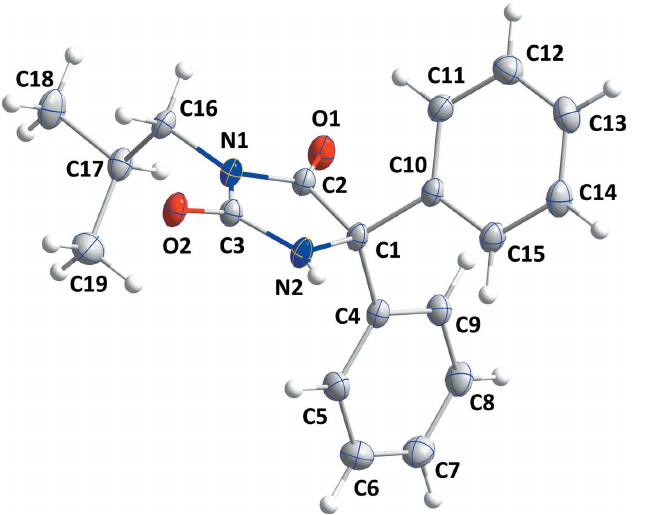
Figure 3 Packing viewed along the c -axis direction with intermolecular inter- actions depicted as in Fig. 2 and non-interacting hydrogen atoms omitted for clarity.